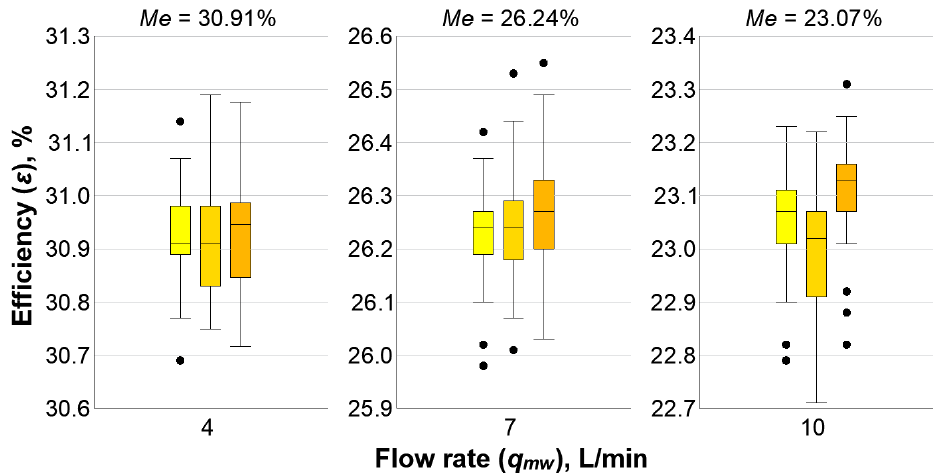
Figure 10. Efficiency of the compact shower heat exchanger determined for T cw = 14 °C during three measurement series ( Me —median of efficiency from three measurement series; • —outliers).